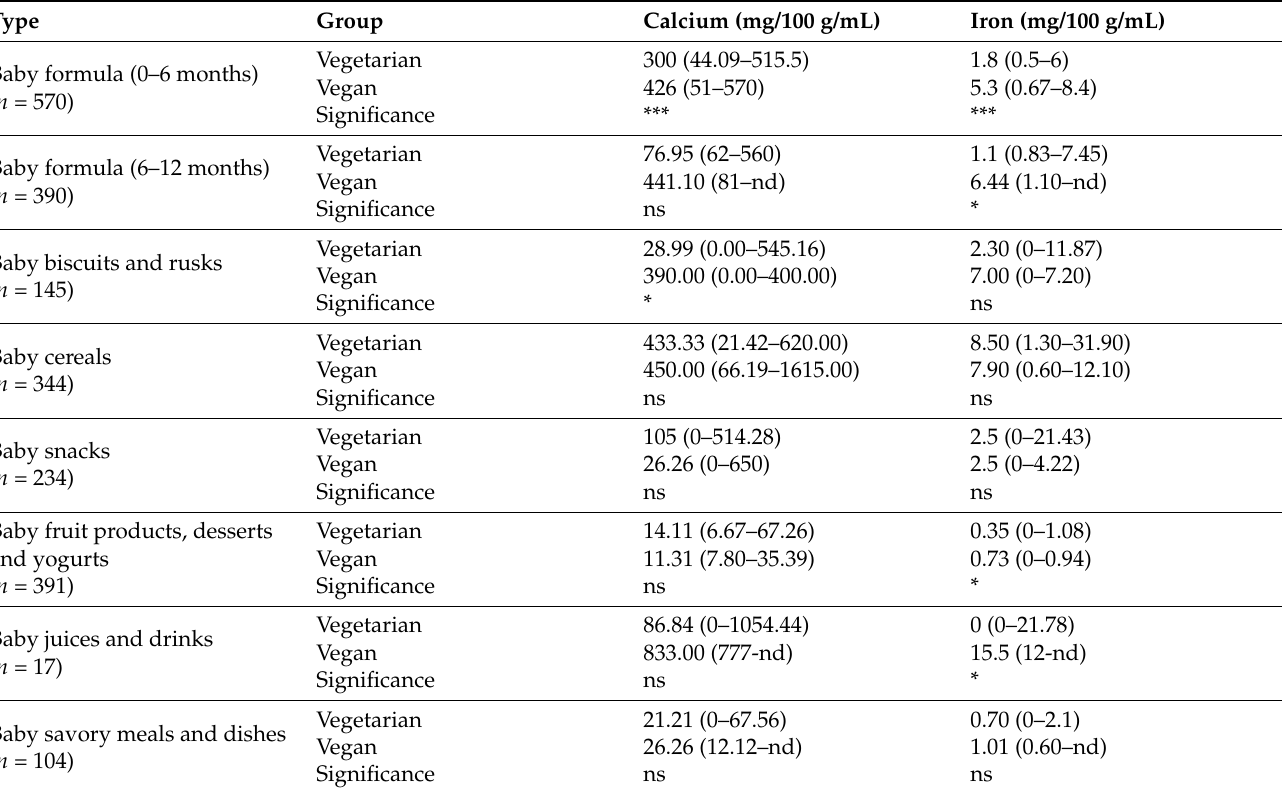
Table 3. Calcium and iron contents of infant